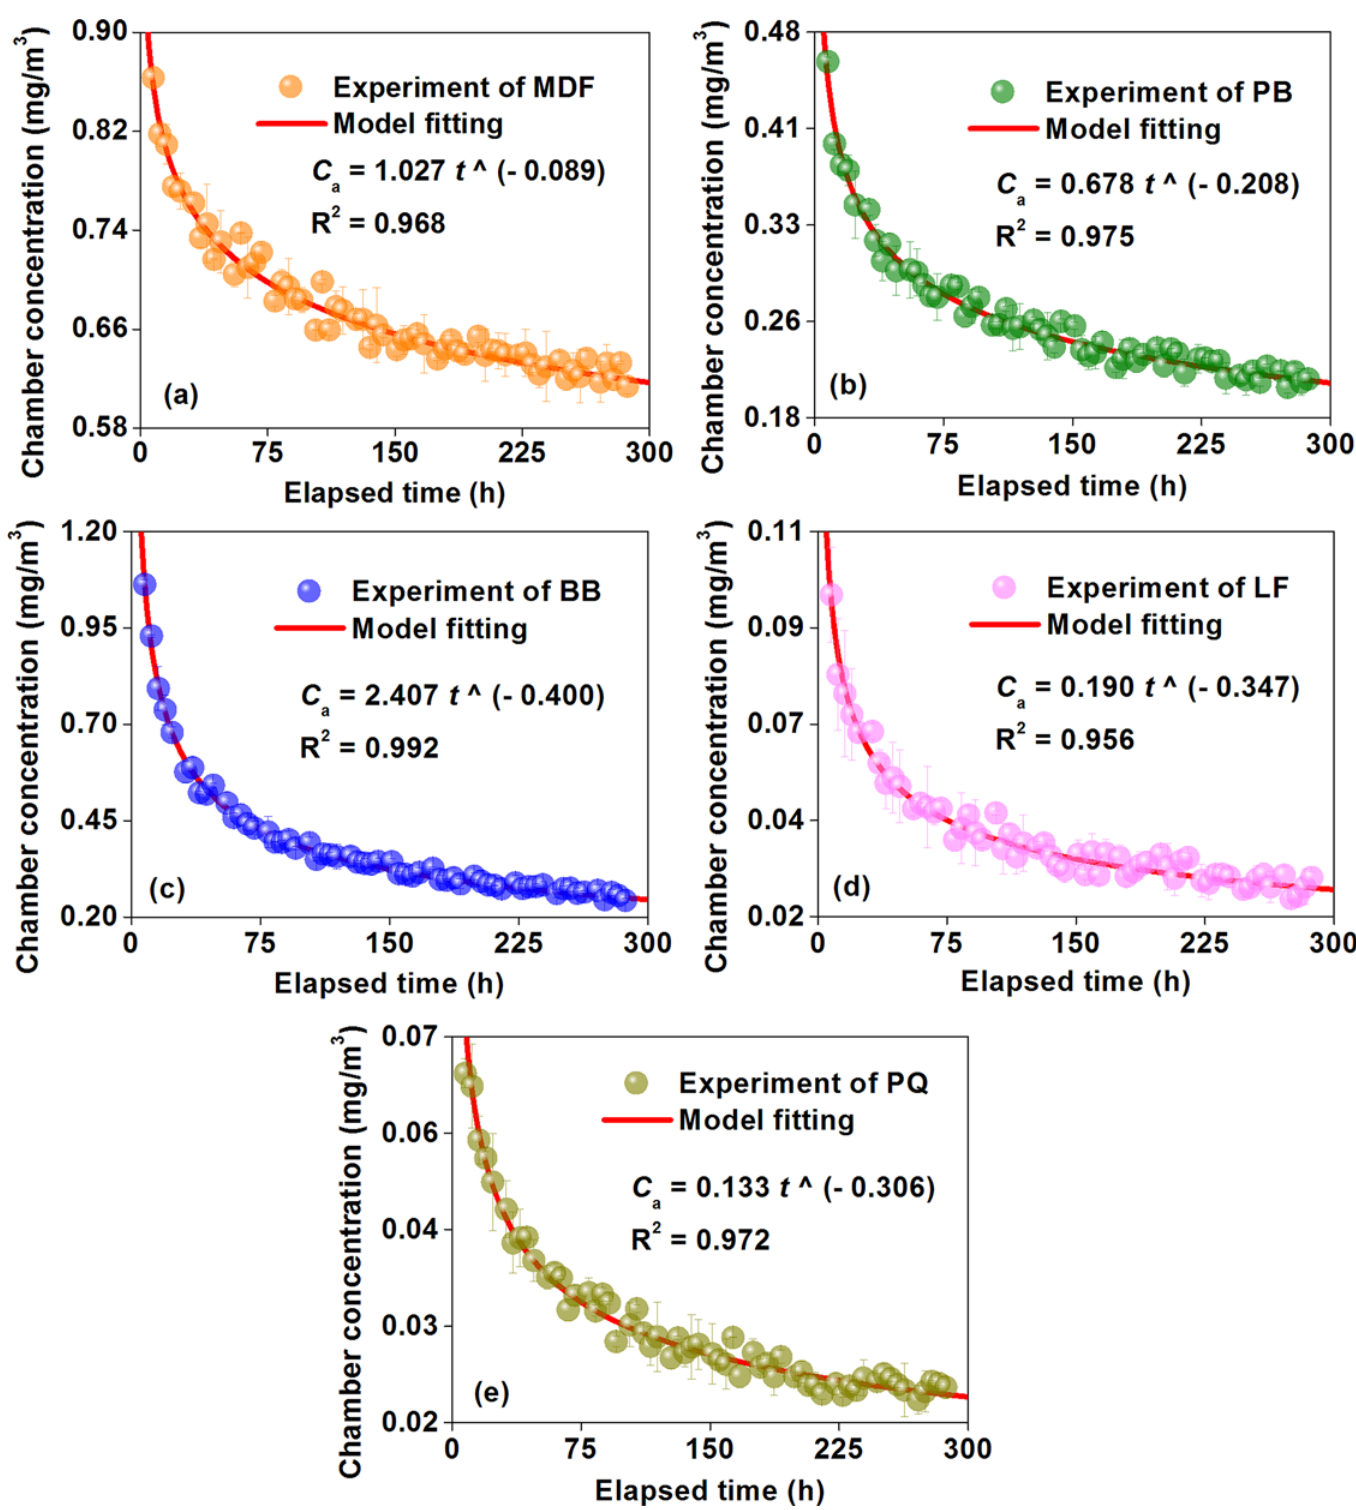
Fig 7. Formaldehyde emission concentrations in the chamber air (chamber concentrations C a ) vs . the test time (or elapsed time t ) of various materials characterized by the environmental chamber method of the Chinese national standard GB 18580. MDF: medium density fiberboard, PB: particleboard, BB: blockboard, LF: laminate flooring, PQ: